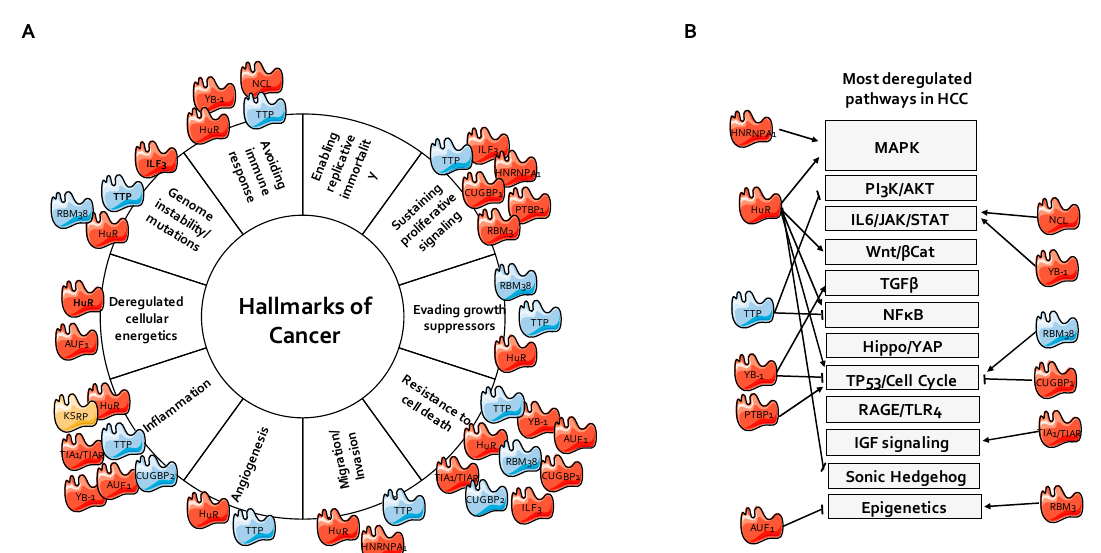
Figure 5. Network of AUBPs involved in liver cancer. ( A ) AUBPs regulating different hallmarks of cancer. ( B ) AUBPs regulating classical signaling pathways deregulated in HCC. The pointed arrows demonstrate positive regulation, while the blunt arrows demonstrate an inhibitory interaction. Red color shows AUBPs upregulated in HCC, blue color shows AUBPs downregulated in HCC patients compared to healthy patients, while orange color shows AUBPs, whose expression is unchanged, based on the Gene Expression Omnibus (GEO) dataset GSE89377. HCC, hepatocellular carcinoma; IGF, insulin-like growth factor; JAK, Janus kinase; MAPK, mitogen-activated protein kinase; NF κ B, nuclear factor kappa-light-chain-enhancer of activated B cells; PI3K, phosphoinositide 3-kinase; STAT, signal transducer and activator of transcription; TGF β , tumor growth factor β ; TLR, Toll-like receptor; YAP, yes-associated protein, RAGE, Receptor for Advanced Glycation Endproducts. Table 1. The validated targets of AUBPs controlling various processes in hepatic cells. BMDMs, bone marrow-derived macrophages; BMSCs, bone marrow-derived stem cells; HCC, hepatocellular carcinoma; HSCs, hepatic stellate cells; PMID, PubMed identifier. AUBP HCC Target Interaction Model / Cell Type Process PMID Fibrosis, ACTA1 Direct HSCs